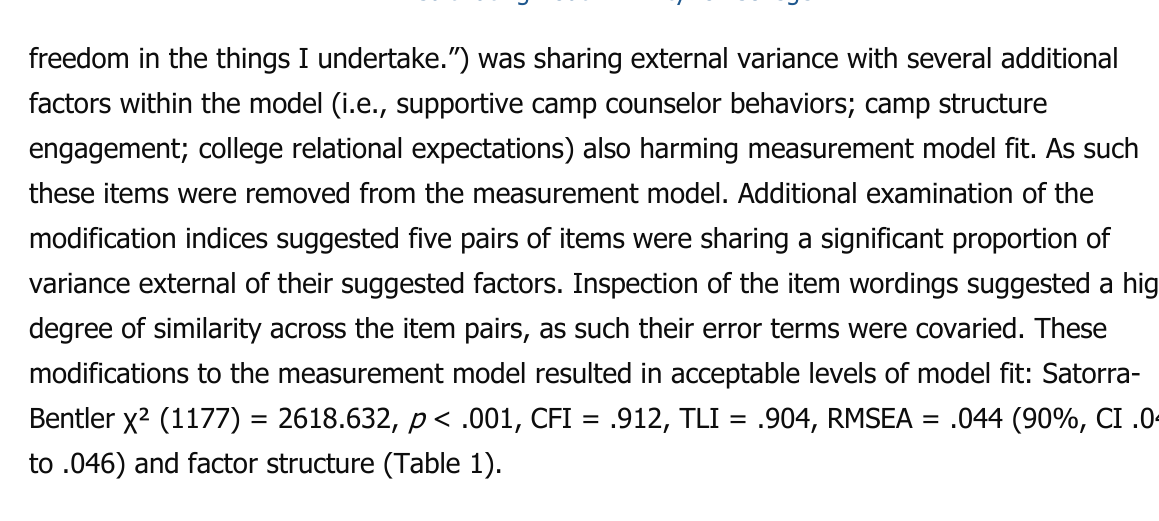
Table 1. Between-Factor